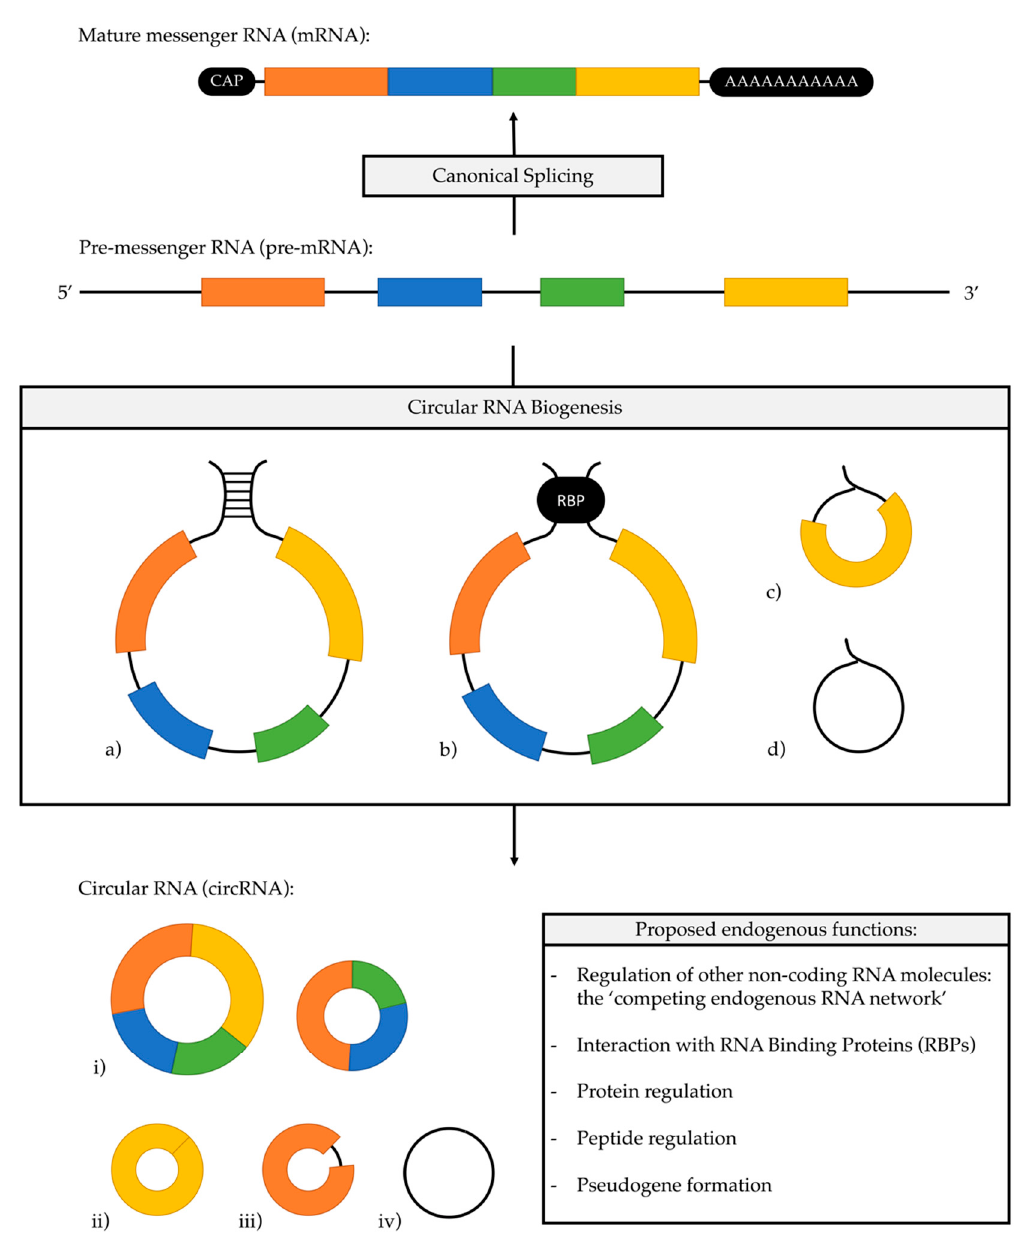
Figure 1. In typical canonical splicing (up), introns are excluded from immature pre-messenger RNA with covalent bonds forming between exons, the mature messenger RNA is completed with a 5 (cid:48) cap and 3 (cid:48) polyA tail; In circRNA biogenesis (down), a “back-splice” junction is formed between the 5 (cid:48) splice donor site and an upstream 3 (cid:48) acceptor site to form a circular molecule. Typical pathways include ( a ) reverse complementary nucleotide sequences in flanking introns, typically long Alu repeats, ( b ) RNA binding protein-mediated, and through lariat precursors, which may be a result of ( c ) exon skipping and ( d ) introns evading degradation; A variety of mature circRNA molecules can form from a single pre-messenger RNA sequence, including ( i ) multi-exonic, ( ii ) single exonic, ( iii ) exon-intronic, and ( iv ) intronic isoforms; Proposed endogenous functions are